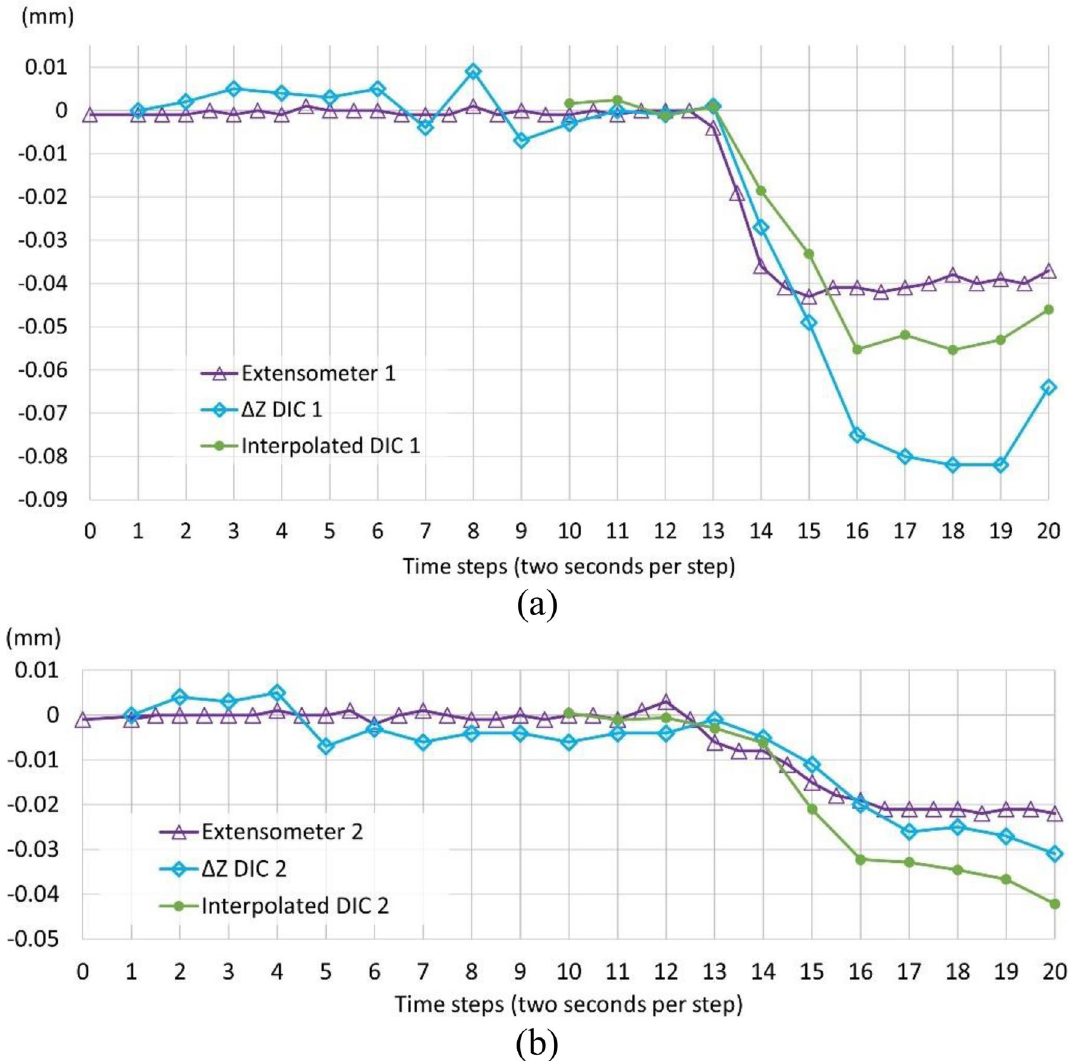
Figure 11. Direct comparison between results from DIC and the extensometer 1 ( a ) and 2 ( b ). The lines represent the cumulative values of: [purple] the Z-displacement from the readings of the contact sensors; [blue] the Z-differences between the fixed and mobile auto-detectable targets placed on sensors from DIC observations (ΔZ DIC); and [green] Z-displacement obtained from the interpolation of DIC-based surface under the contact